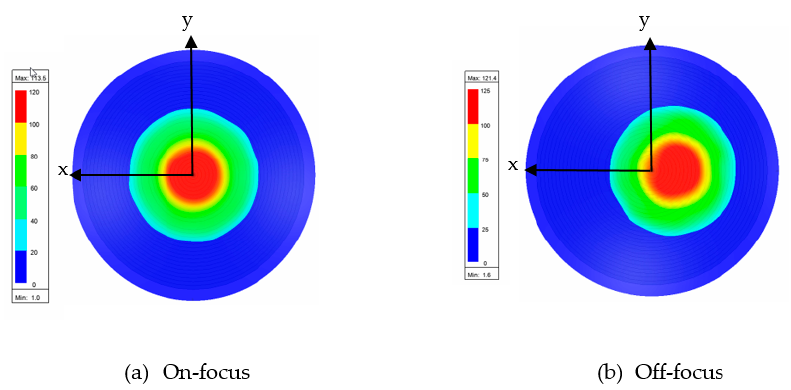
Figure 16. Electric intensity distribution.